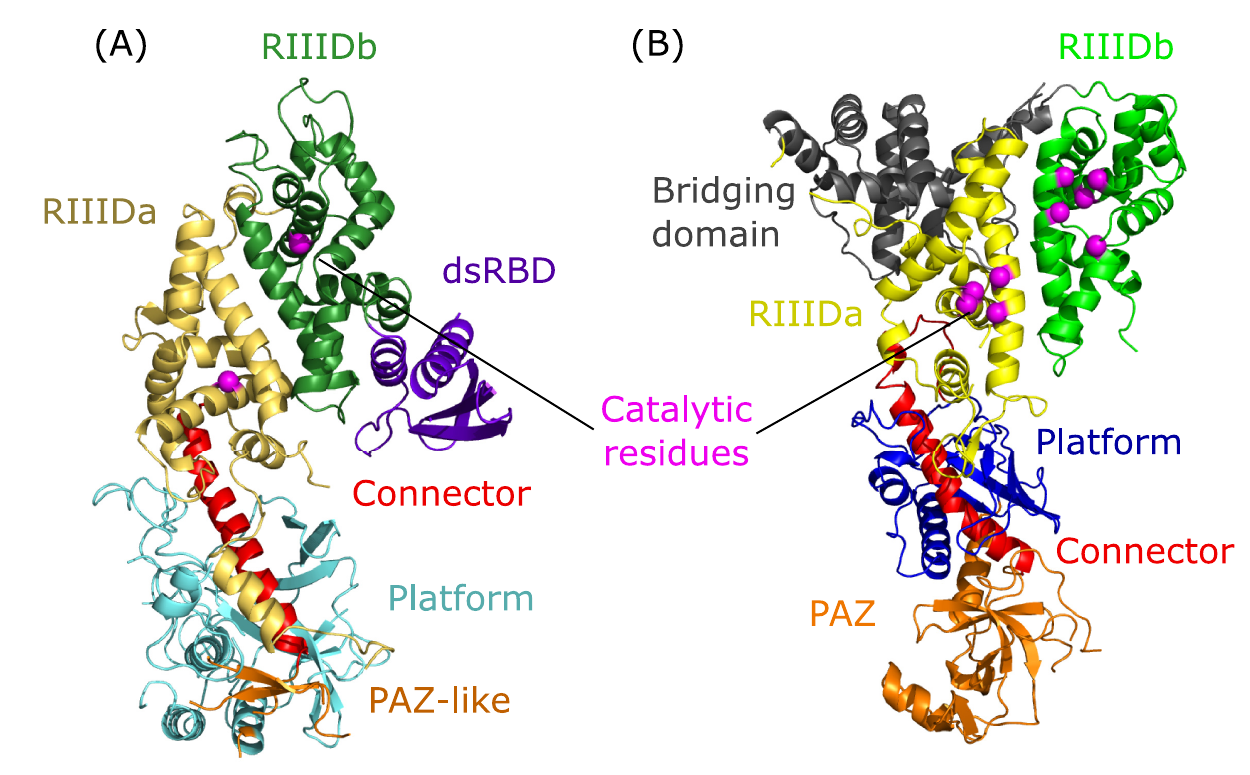
Fig 1. Structures of human Drosha and Giardia Dicer. Front view ribbon representation of the structure of (A) Drosha and (B) Dicer. The proteins are colored with similar colors for similar domains. Domains colors are as follow: N-terminal Platform domain (Drosha: cyan, Dicer: dark blue), putative PAZ- like and PAZ domains (Drosha and Dicer: orange), Connector (red), RIIIDa (Drosha: gold, Dicer: yellow), RIIIDb (Drosha: green-forest, Dicer: light green), Dicer Bridging domain (gray), Drosha dsRBD domain (purple). The catalytic residues of both RIIID domains are represented as magenta spheres.